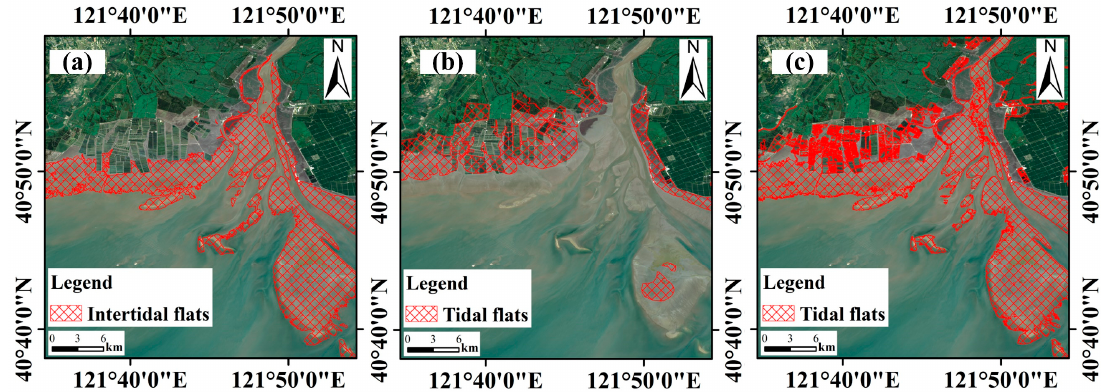
Figure 11. Detection of tidal flats in Liaohe Estuary within (a) our map, (b) LUCC 2015 and (c) Murray’s, respectively. The base map from Landsat OLI acquired on 9 August 2018 is displayed in true color.